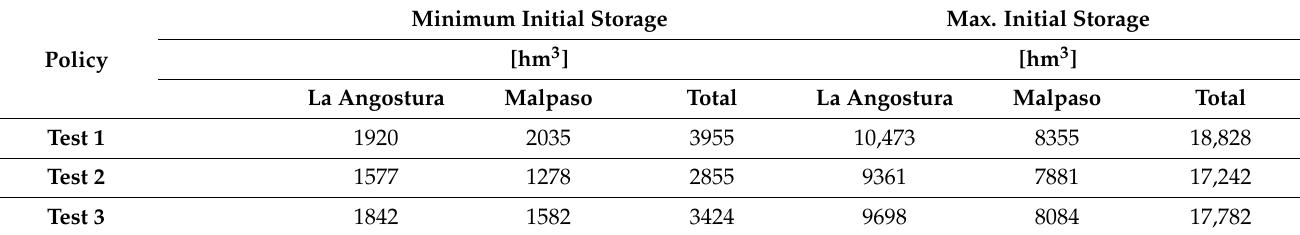
Table 4. Results of the tested policies: minimum and maximum initial storage.